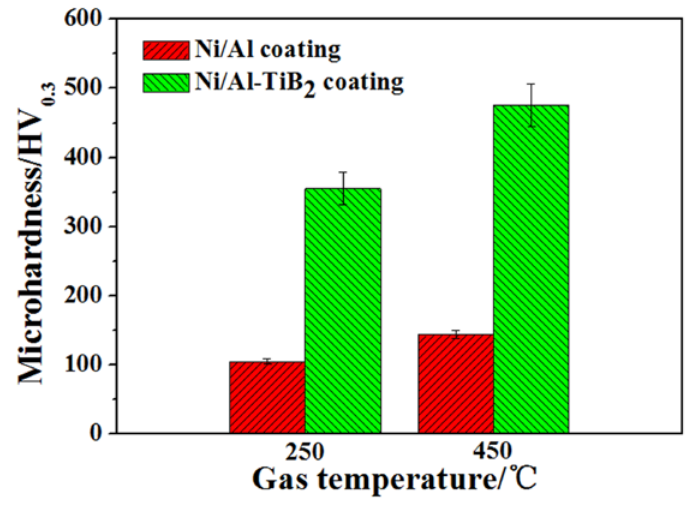
Figure 6. Microhardness of Ni/Al and Ni/Al-TiB 2 coatings.